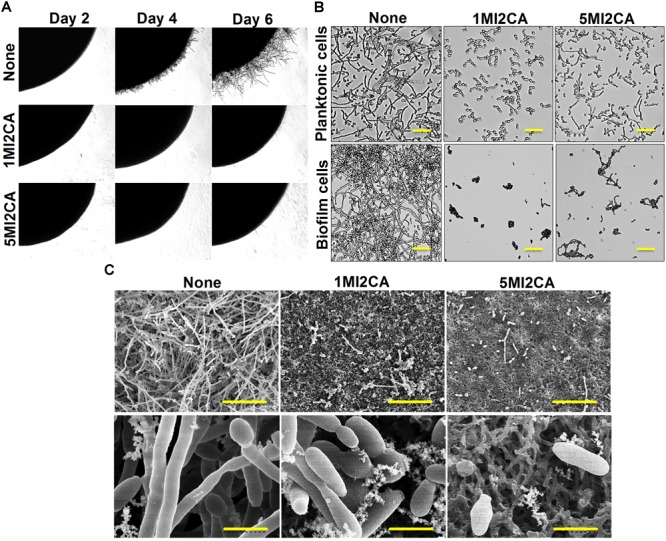
Effects of 1MI2CA and 5MI2CA on C. albicans DAY185 morphology and hyphal growth. C. albicans morphology on solid media (A). C. albicans was streaked on PDA agar plates supplemented with 10% fetal bovine serum in the absence or presence of 1MI2CA or 5MI2CA (0.1 mM). Colony morphologies were photographed every 2 days at 37°C. Inhibition of the hyphal growths of planktonic and biofilm cells of C. albicans
(B). C. albicans was grown in PDB medium in the absence or presence of 1MI2CA or 5MI2CA (0.1 mM) at 37°C. Cultures were sampled after 24 h and photographed under a bright field microscope. The scale bar represents 100 μm. Microscopic observations (SEM) of the effects of the two methylindoles (0.1 mM) on biofilms and hyphal formation (C). C. albicans cells were grown on nylon filter paper in the presence or absence of 1MI2CA or 5MI2CA and visualized by SEM. Scale bars represent 50 and 5 μm, respectively. At least two independent experiments were conducted. None indicates untreated control cells.